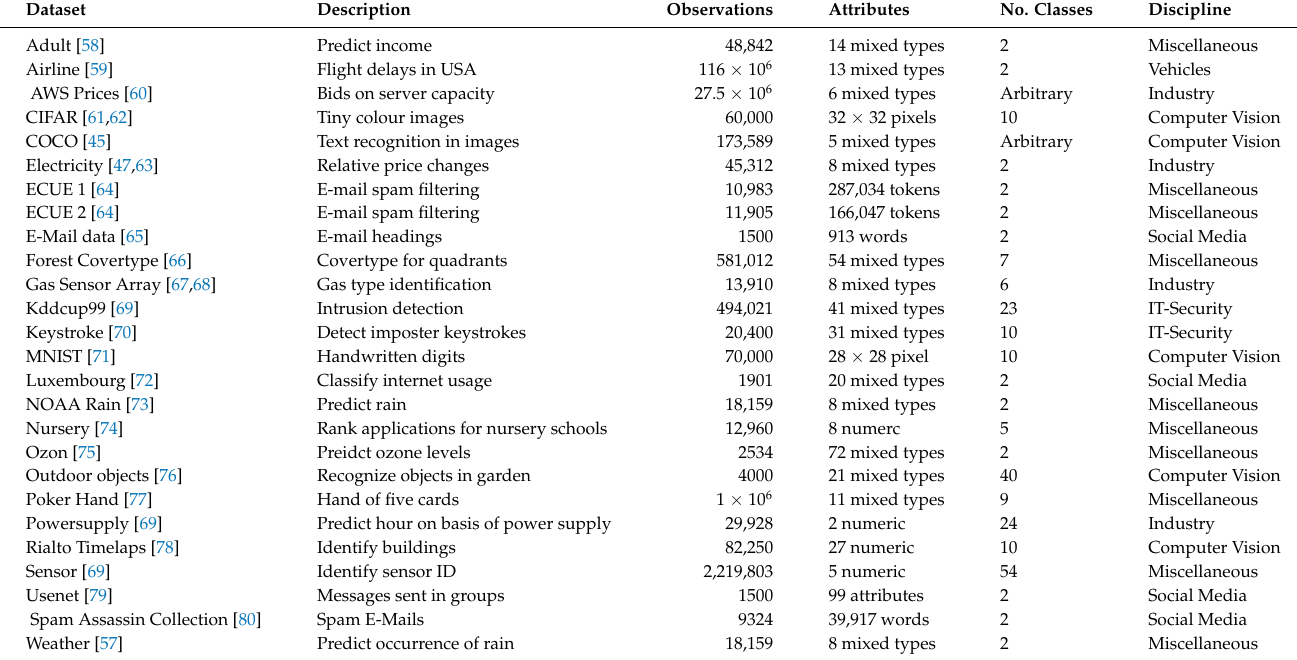
Table 3. Real-world datasets from different application scenarios of stream